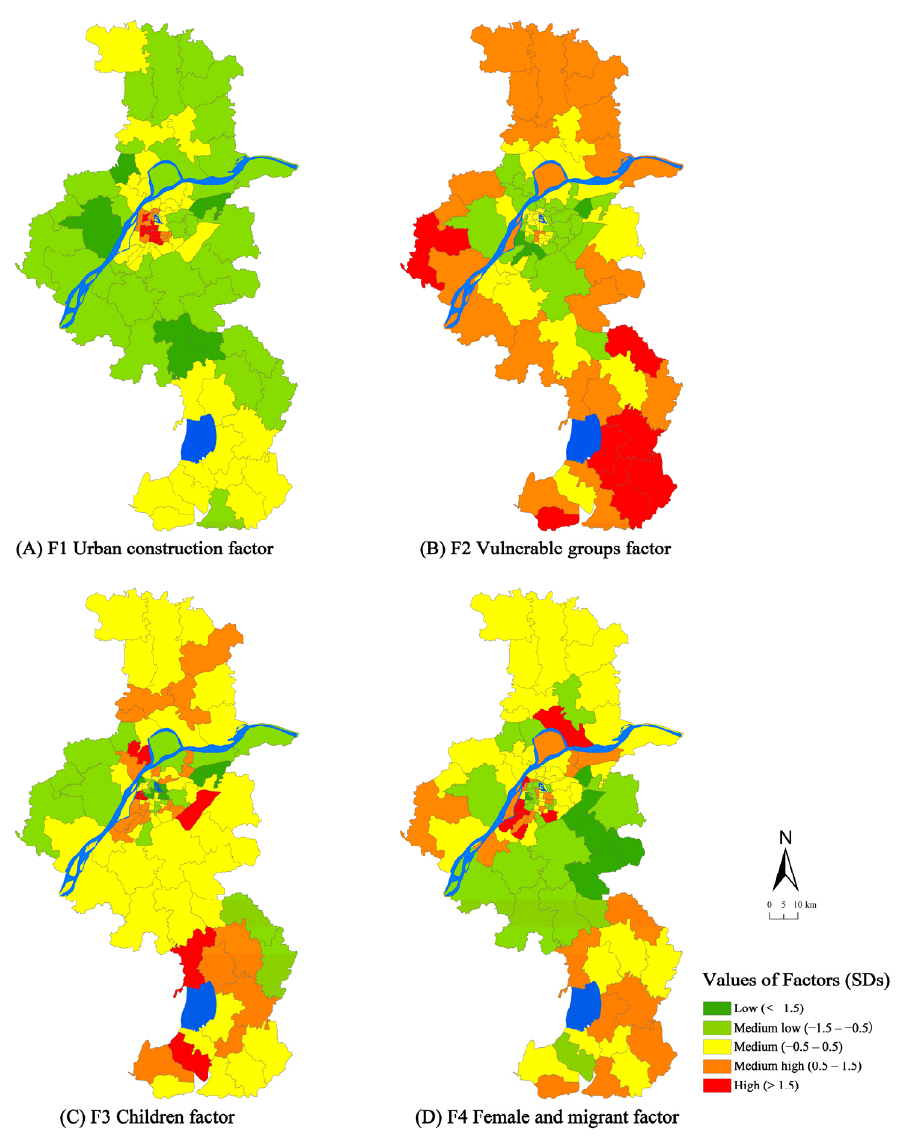
Figure 3. The spatial pattern of all factors of social vulnerability in Nanjing. The Vulnerable Groups factor (Factor 2) scored low in the urban centre and high in exurban areas, exhibiting a central–peripheral pattern in general (Figure 3). The elderly and people with low education are distributed in exurban areas. These areas have higher social vulnerability than the urban centre and suburban areas. The rapid increase in the cost of urban housing has made it difficult for vulnerable groups, such as low-income individuals, to buy homes in the city centre; renters are also more vulnerable than homeowners to flood [40]. The enlarged gap in housing prices pushed vulnerable groups to live in exurban areas [39]. The older populations are more vulnerable than others due to mobility and health issues [40]. Low and medium scores were recorded in urban and suburban areas, respectively; residents in these areas have a relatively high income and education level, making them more conscious of flood risk than